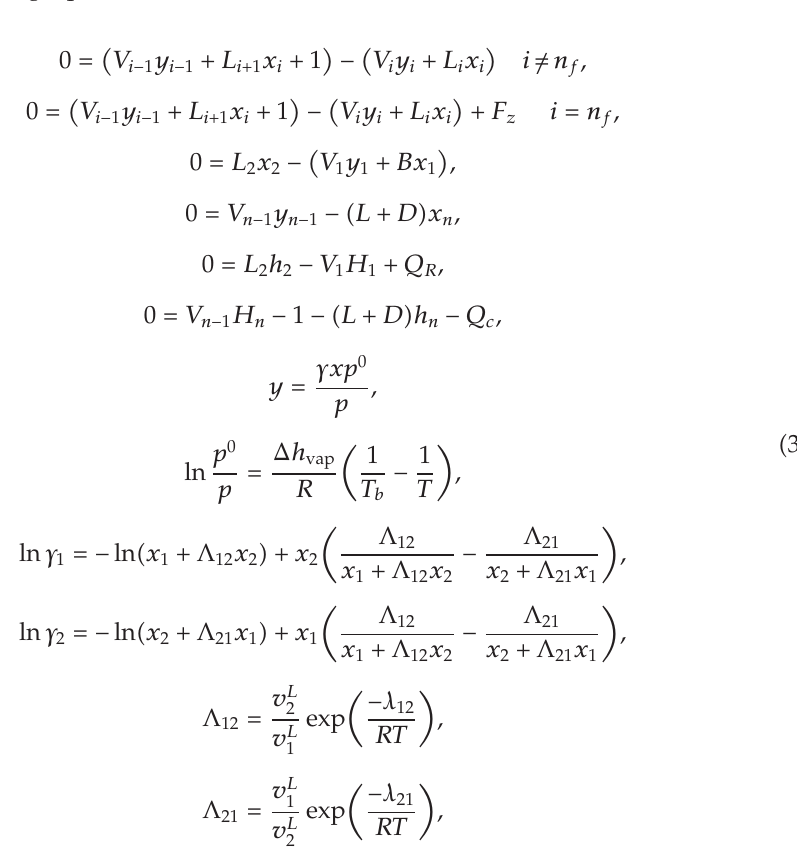
The following equations describe the